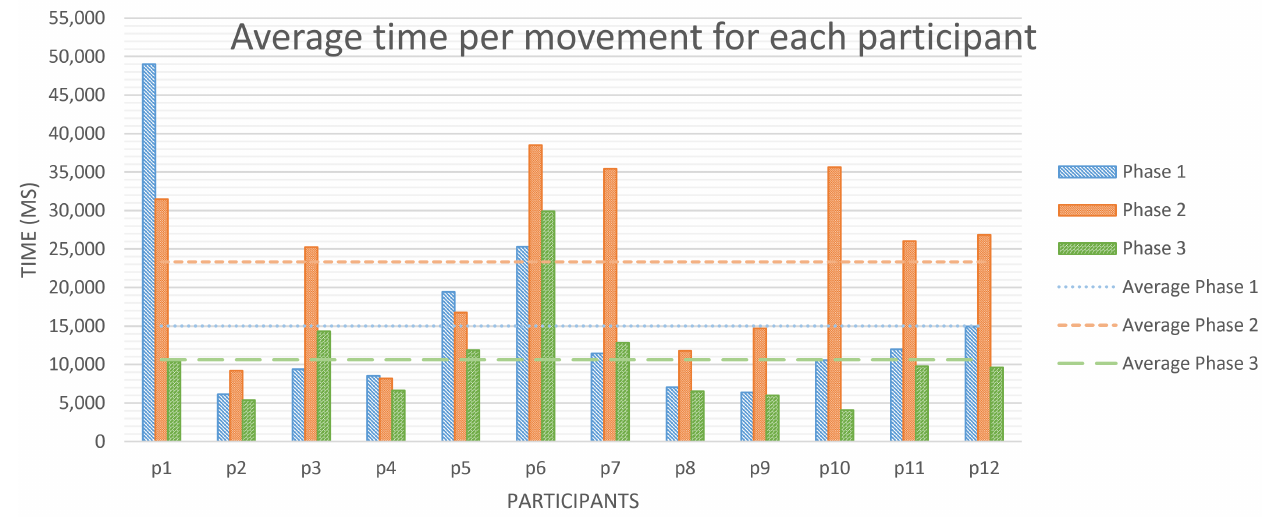
Figure 6. Average time per movement, in milliseconds, for every player in each